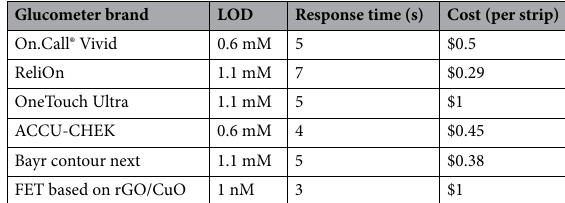
Table 3. Comparing the developed sensor to other commercially available electrochemical strips.